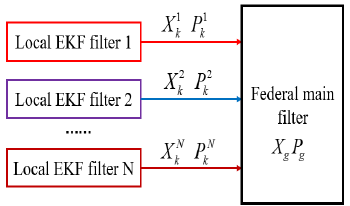
Figure 3. The improved federated EKF fusion